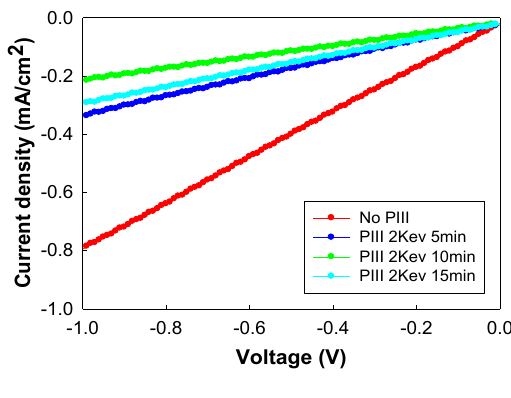
Figure 11. The I-V characteristic curve comparison of without PIII & PIII 2 KeV 10 min heterojunction solar cells without AlO